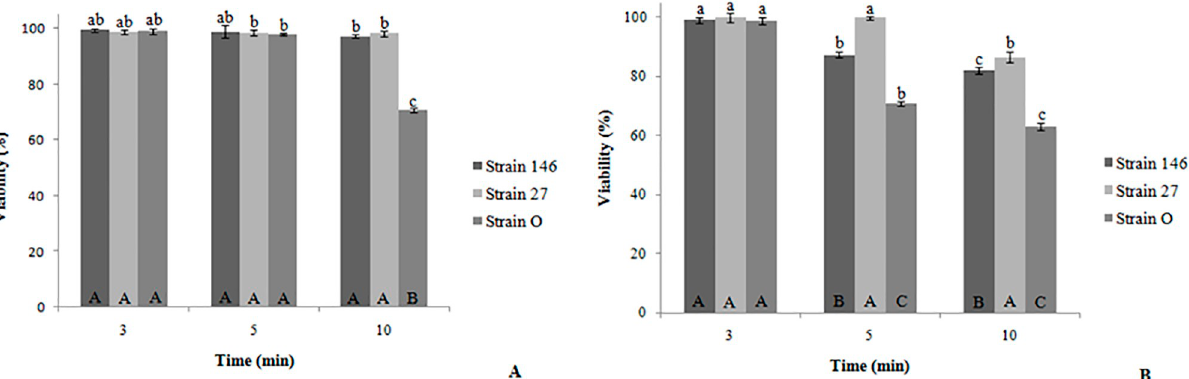
Fig 5. Effect of heat shock treatment on the viability of yeasts. After exposure to 45˚C (A) and 50˚C (B) for 3, 5 and 10 min, cells were ten-fold serially diluted and plated on YEPD agar, followed by incubation at 25˚C for 48 h. Mean values marked with identical letters are—according to the Tukey test (p < 0.05)—not significantly different. Lowercase letters correspond to the comparison between each stressed yeast and its control. Uppercase letters represent the comparison between yeasts at a certain